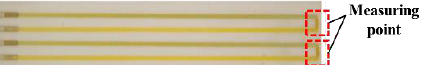
Figure 3. Two thin-film thermocouples fabricated by sputtering onto a ceramic substrate